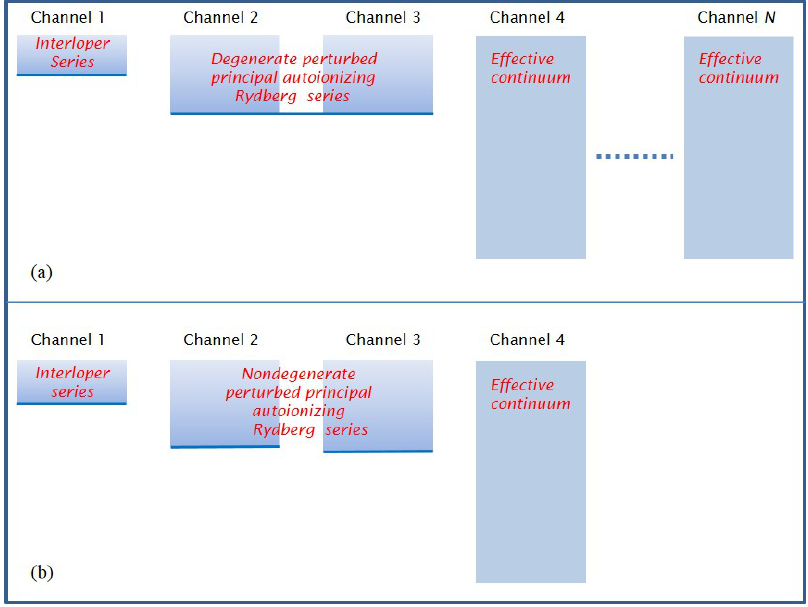
Figure 6. Schematic diagram of the channel structures of the systems involving three closed and many open channels.